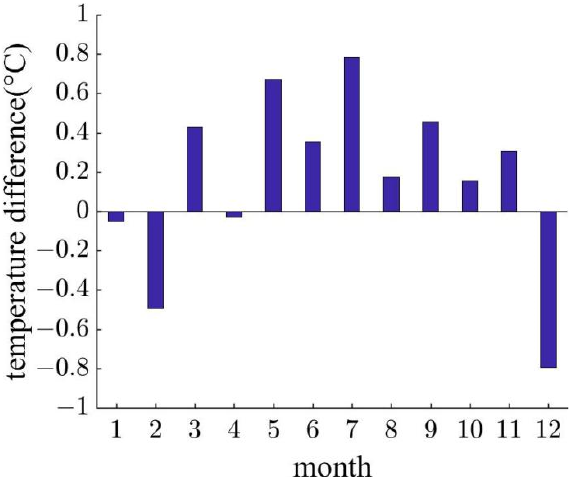
Figure 2. Temperature difference of monthly average temperature between 2010 − 2019 and 1980–2009 in Jilin Province, China.